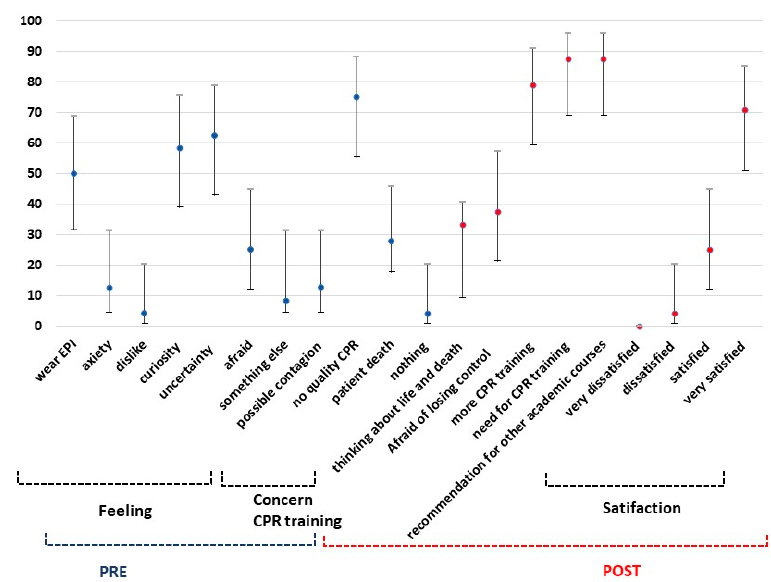
Figure 2. Prevalence of students’ thoughts and feelings (with IC 95%) regarding to the cardiopul- monary reanimation.